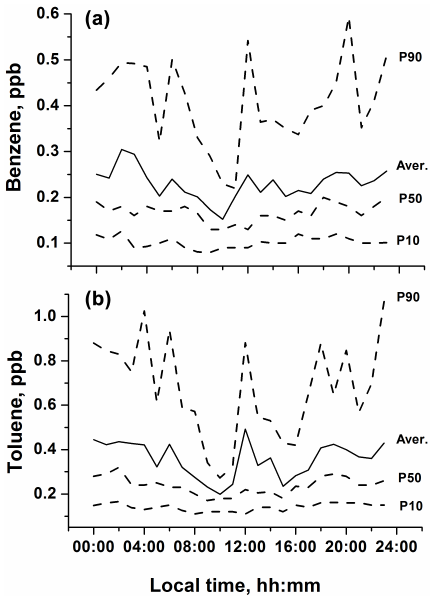
Figure 4. Diurnal profiles of the surface levels of benzene and toluene from TROICA-12 (hourly mean values): average (solid) and percentiles (dashed).